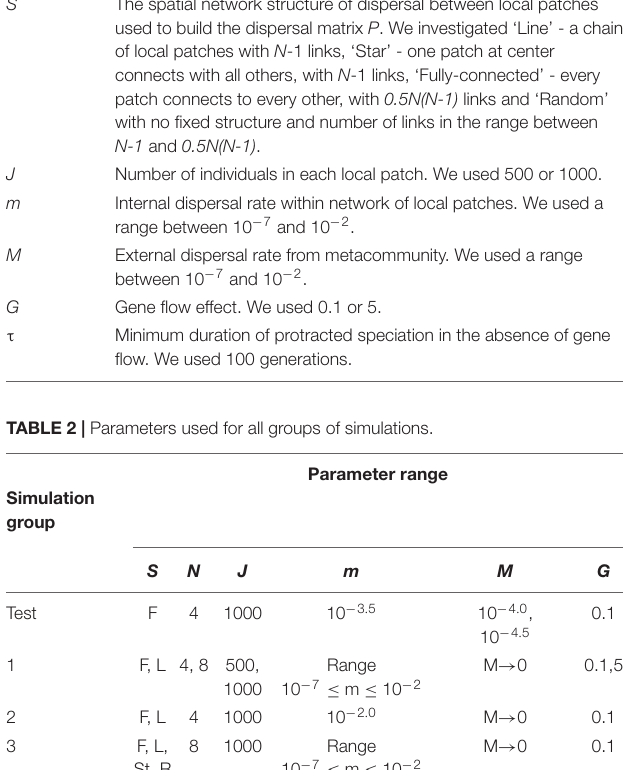
TABLE 1 | A list of all parameters used in our simulations and their meaning. Parameter Explanation N Number of local patches in the network. We used 4 or 8. S